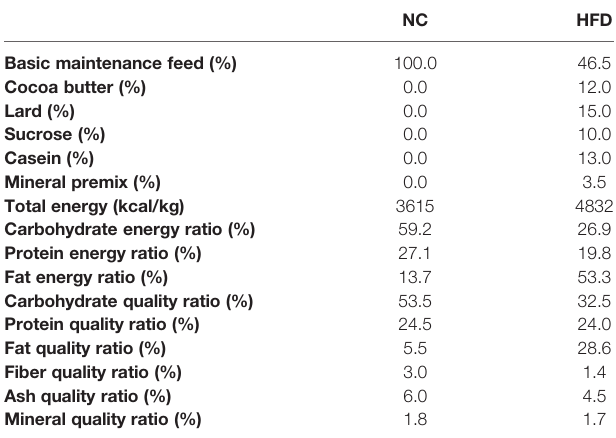
TABLE 1 | Ingredient and macronutrient composition of the diets fed to dogs. NC HFD Basic maintenance feed (%) 100.0